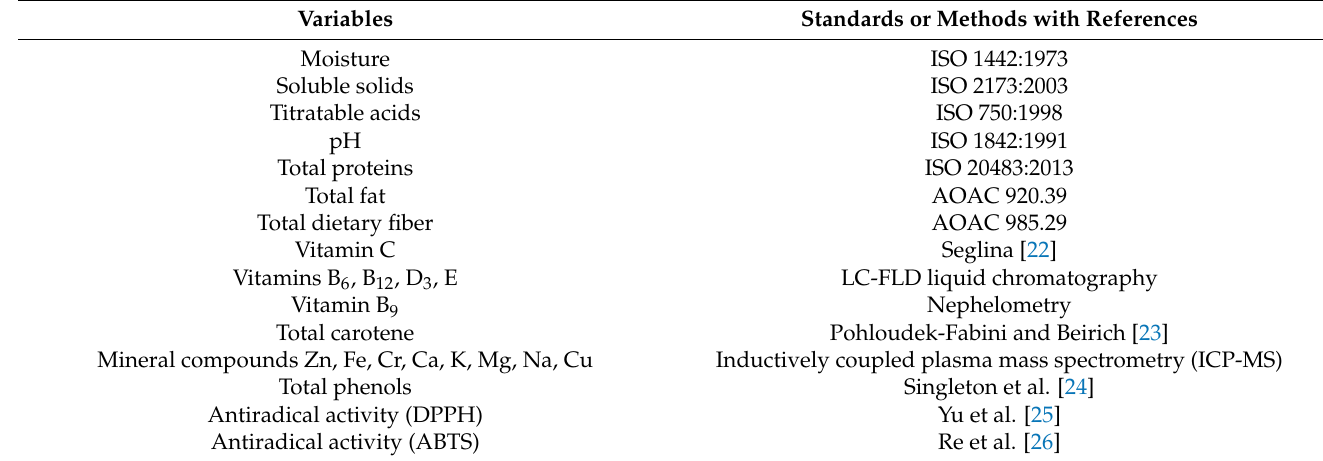
Table 3. Methods and standards used for plant-based pur é e prototype quality